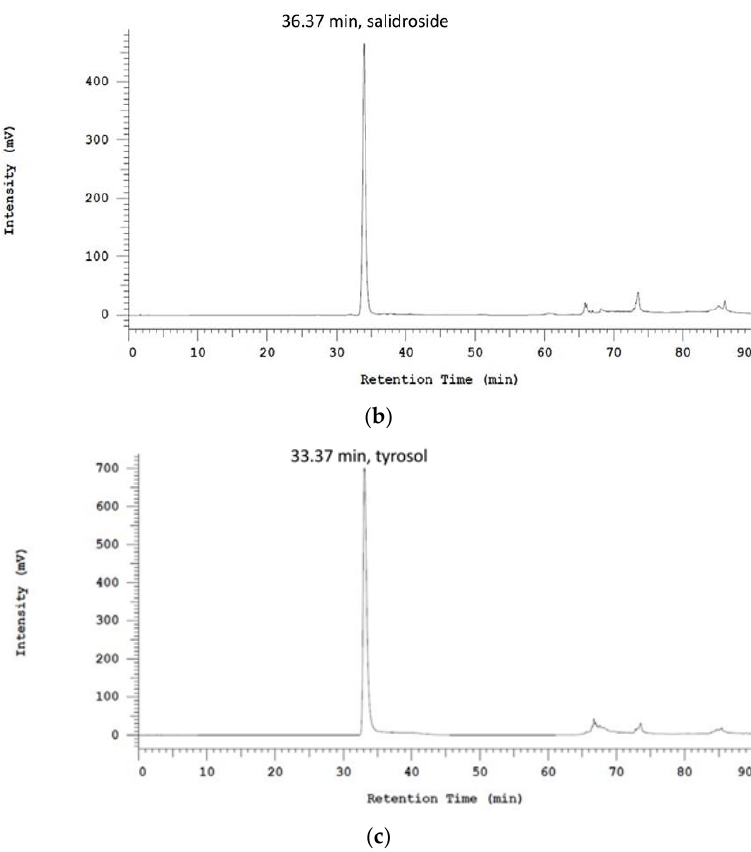
Figure 1. HPLC profiling data of Rhodiola crenulata root extract ( a ), salidroside ( b ), and tyrosol ( c ). The assay was performed as described in the Materials and Methods section. Detection was performed at a wavelength of 223 nm.